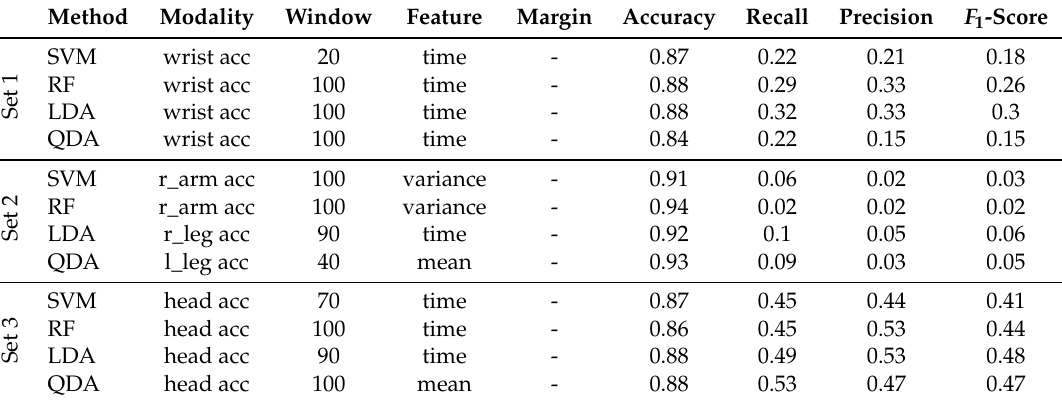
Table 3. Results for individual top experiment runs (by recall), per dataset for supervised methods, via classic multiclass scoring (the feature extraction window is the number of samples (@50Hz); the extracted feature is mean, variance or time (time = mean/var/range/median); the transition scoring margin is the number of samples) (datasets numbered as listed in Section